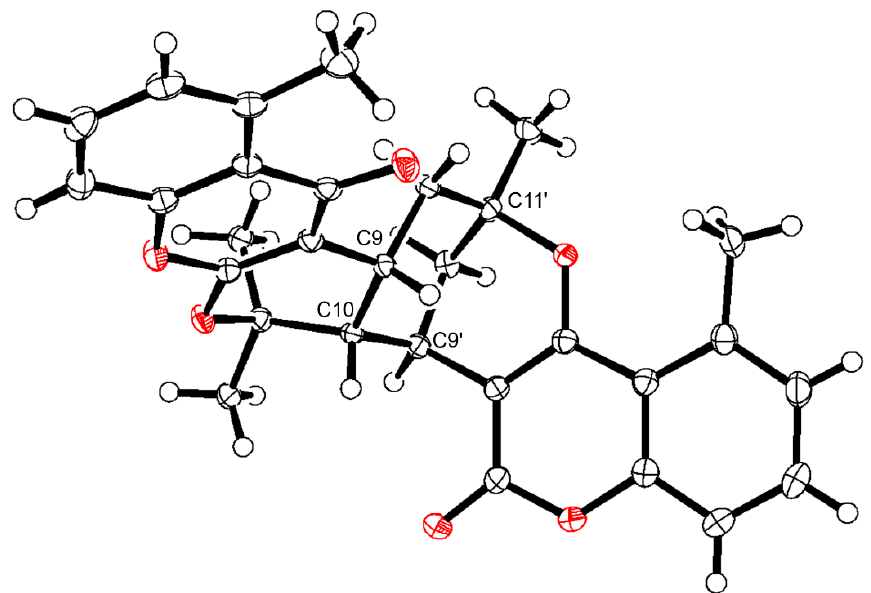
Figure 8. Perspective drawing (ORTEP-3) of 19 . Displacement ellipsoids of the non-hydrogen atoms are shown at the 50% probability level. Hydrogen atoms have been shown as spheres of arbitrary size. Oxygen atoms are red.